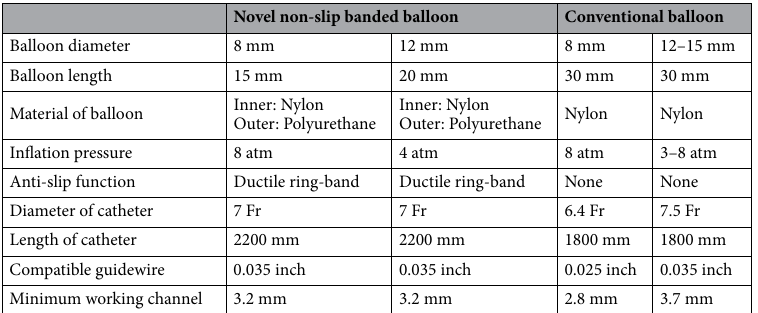
Table 1. Characteristics of the balloon catheters used in this